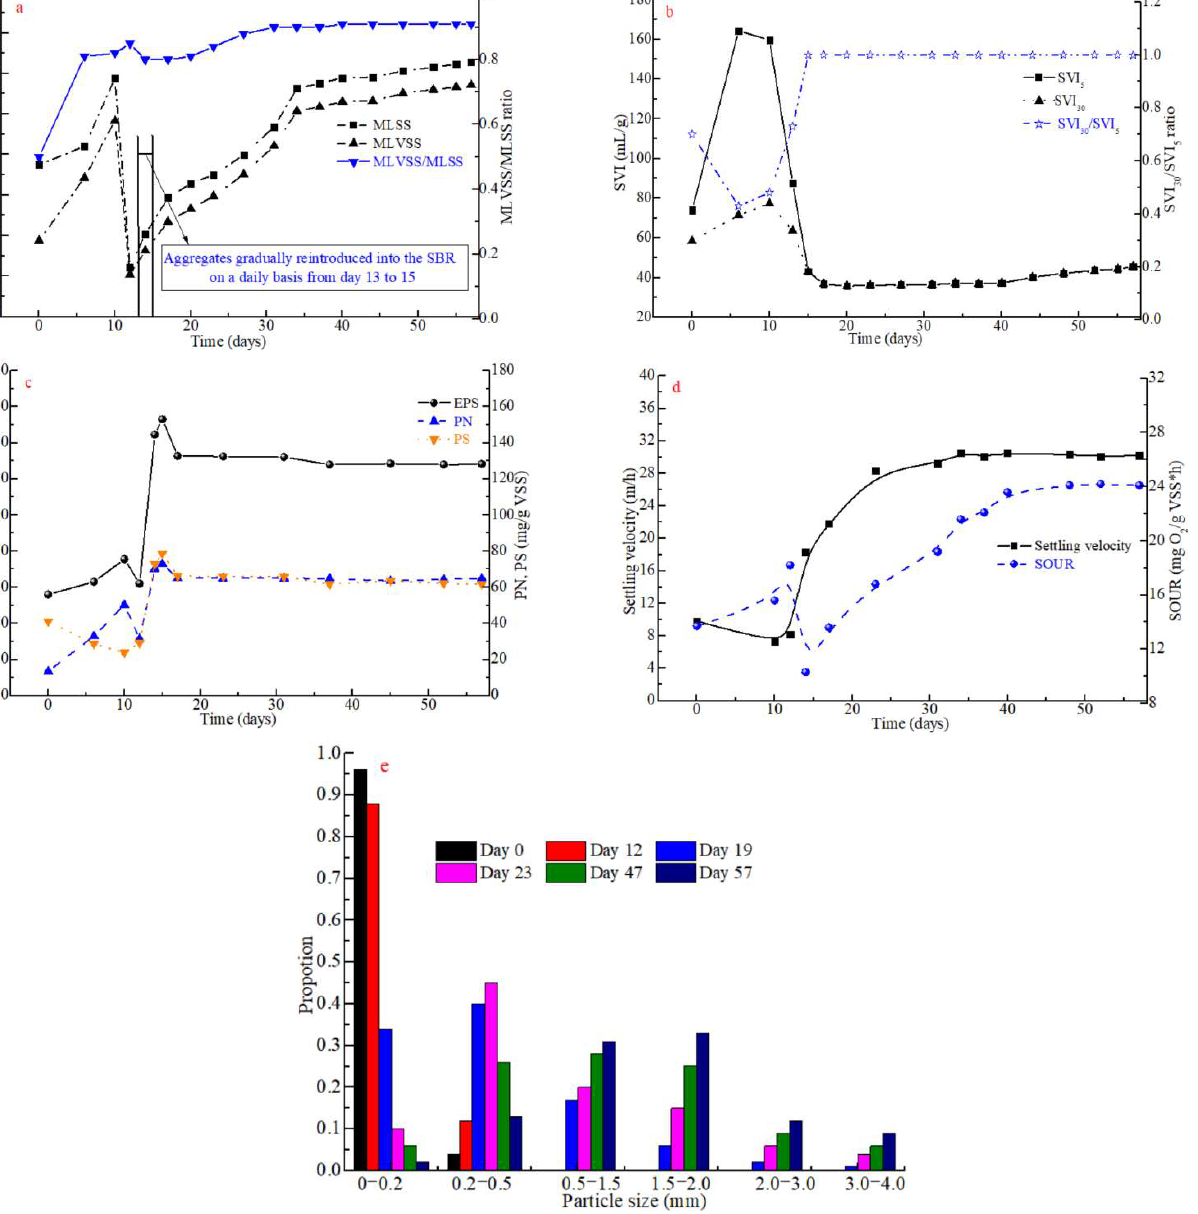
Figure 4. Evolution of sludge particles throughout the rapid granulation process in regard to their ( a ) MLSS and MLVSS, ( b ) SVI 5 and SVI 30 , ( c ) EPS, ( d ) SOUR and settling velocity and ( e ) size distri- bution.